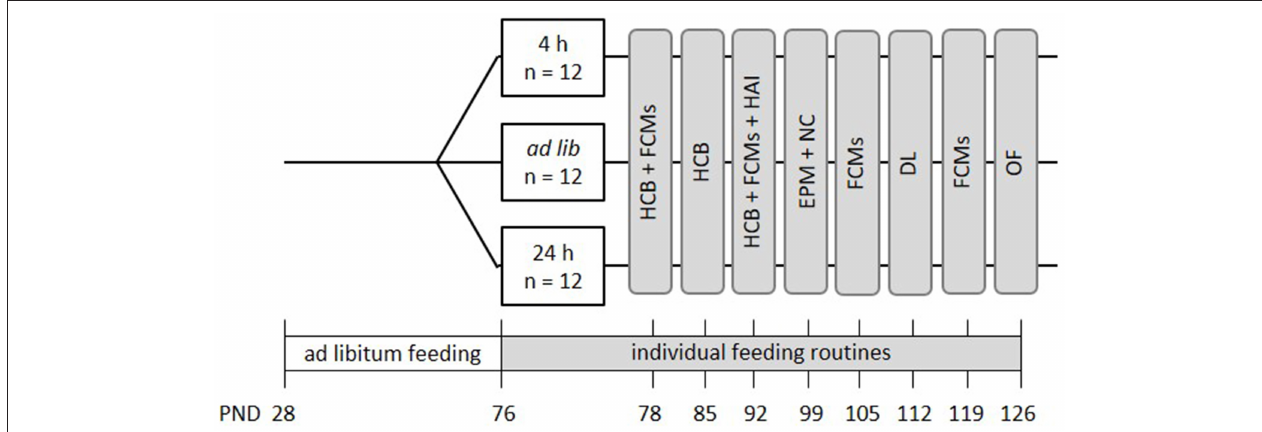
FIGURE 1 | Schematic timeline of experiment 1. From PND 76 on, the animals were subjected to individual feeding routines and either fed ad libitum ( ad lib ), according to the 4h removal (4h) or the 24h schedule (24h). They were kept to this diet for a total experimental time of 8 weeks. Effects on animal welfare were evaluated by home cage behavior observations (HCB), measurements of fecal corticosterone metabolites (FCMs), and different behavioral tests, including the Human-Animal Interaction Test (HAI), the Novel Cage Test (NC), the Elevated Plus Maze Test (EPM), the Dark-Light Test (DL) and the Open Field Test (OF). All information on PNDs have an accuracy of ± 2 days. Please note that in this experiment no base values of corticosterone metabolite concentrations were